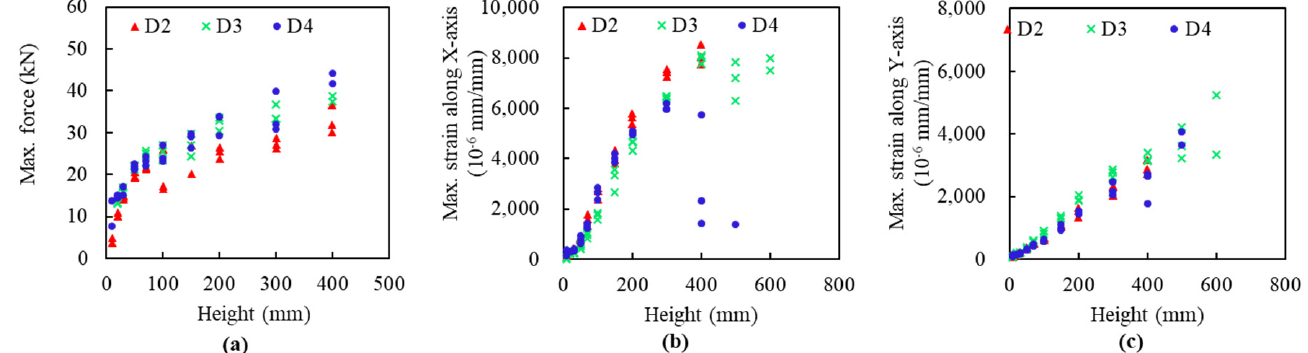
Figure 14. Comparison among D1, D2, and D3 for peak values under different impact heights: ( a ) Maximum forces, ( b ) Maximum strain along X-axis, ( c ) Maximum strain along Y-axis.